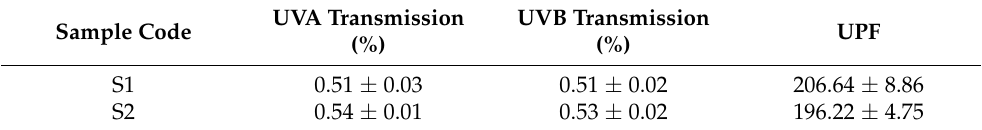
Figure 11. The UV transmittance of the Song Brocade fabrics with and without Ag-PA yarns over 290–400 nm. Table 5. Results of UV shielding effectiveness from Figure 11.